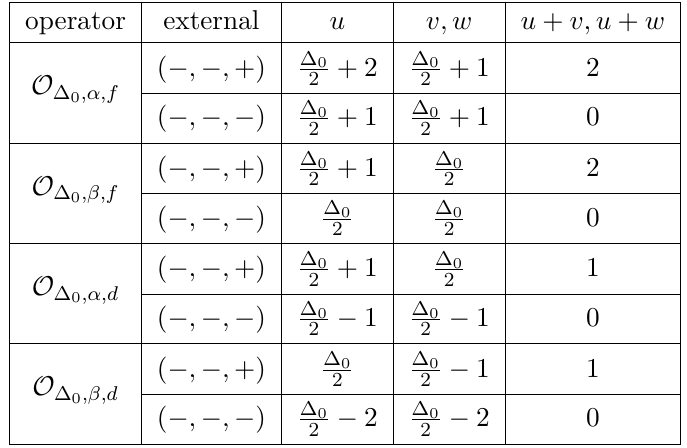
Table 11 . Powers of leading spurious poles contained by individual degree parts. ∆ 0 denotes the canonical dimension of the